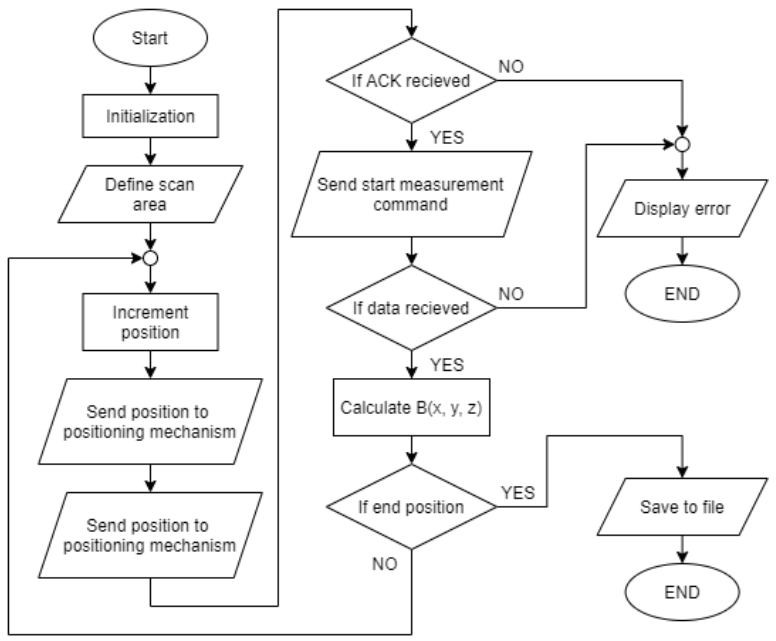
Figure 13. Measurement procedure flowchart.